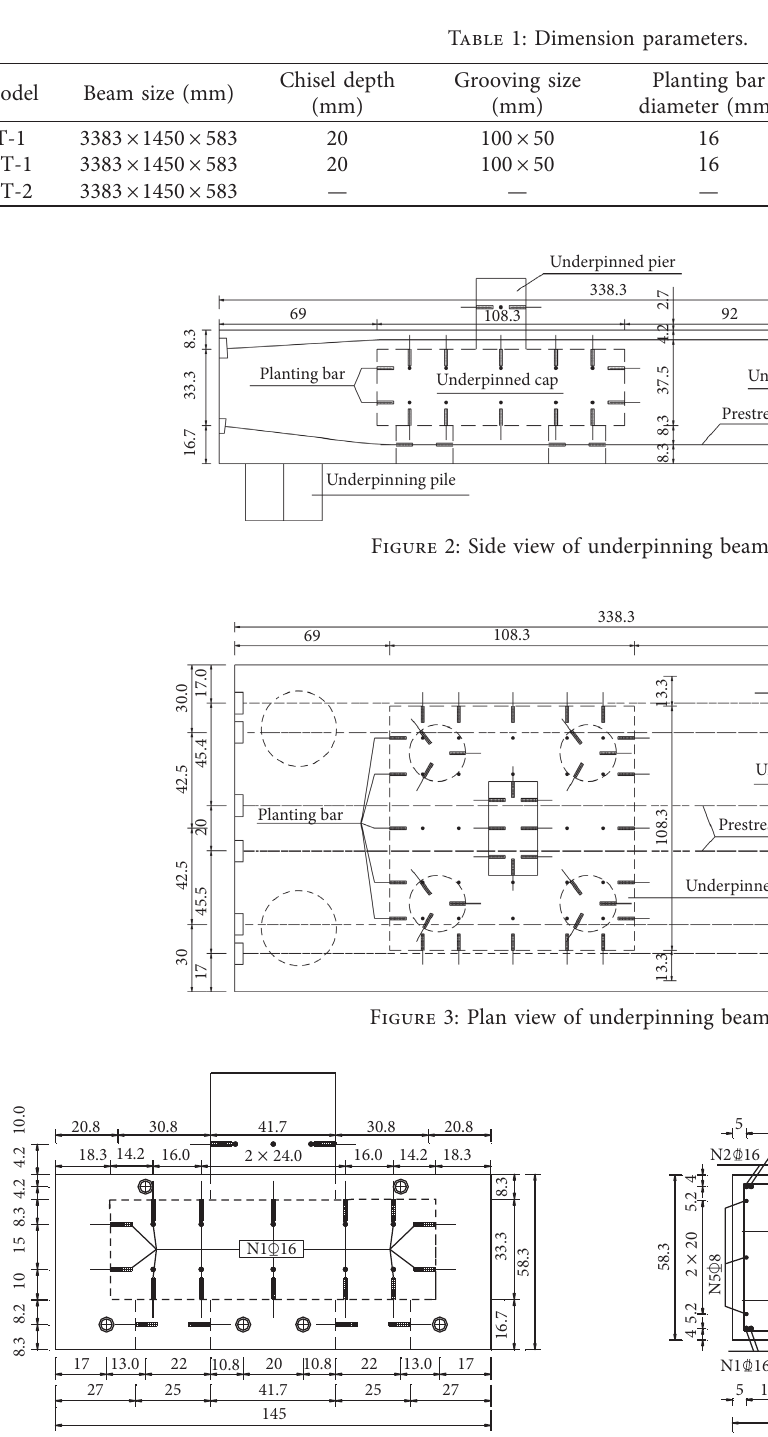
Figure 4: Planting bars drawing (cm). Figure 5: Reinforcement drawing